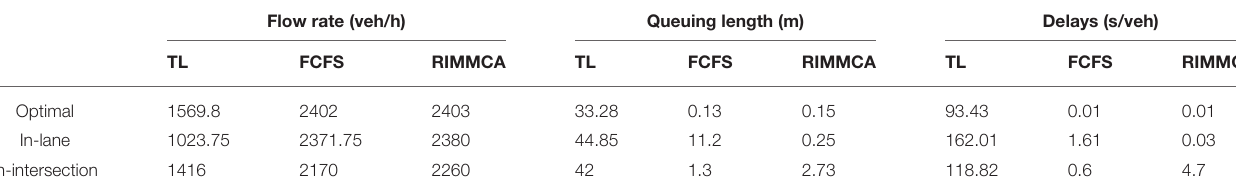
TABLE 2 | A performance comparison table between three intersection controls in different experiment